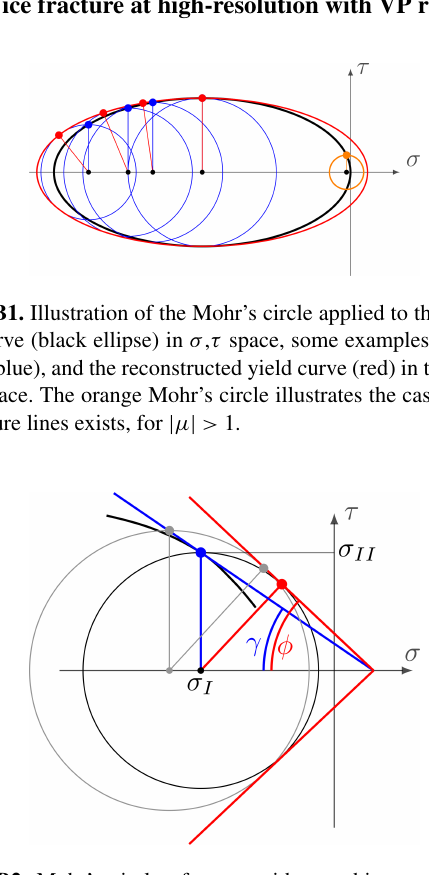
Figure B2. Mohr’s circle of stress with an arbitrary yield curve (black line) in the fracture plane reference. tan (γ) = µ is the tan- gent to the yield curve, and φ is the internal angle of friction as described in Appendix A. We note that sin (φ) = tan (γ) = µ (for | µ | ≤ 1). For a slightly different Mohr’s circle (grey), the blue and red tangents meet in the same point on the σ